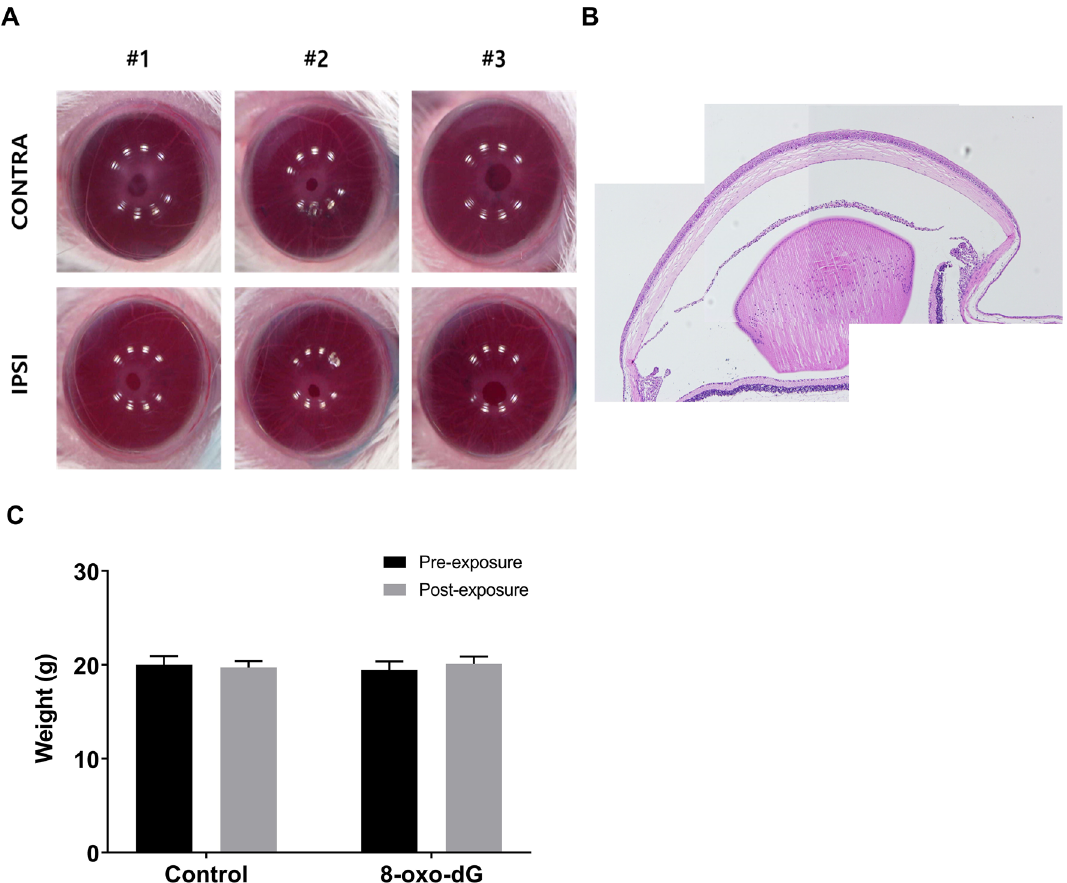
Figure 7. Biological changes observed after repeated administration of topical 8-oxo-2 ′ -deoxyguanosine (8-oxo-dG) for 3 days (total 24 times). ( A ) Clinical images of cornea after repeated exposure. ( B ) Histologic findings of the whole eyeball after repeated exposure of 8-oxo-dG. ( C ) Comparisons of mouse body weight between pre-exposure and post-exposure. IPSI application of 8-oxo-dG, CONTRA no